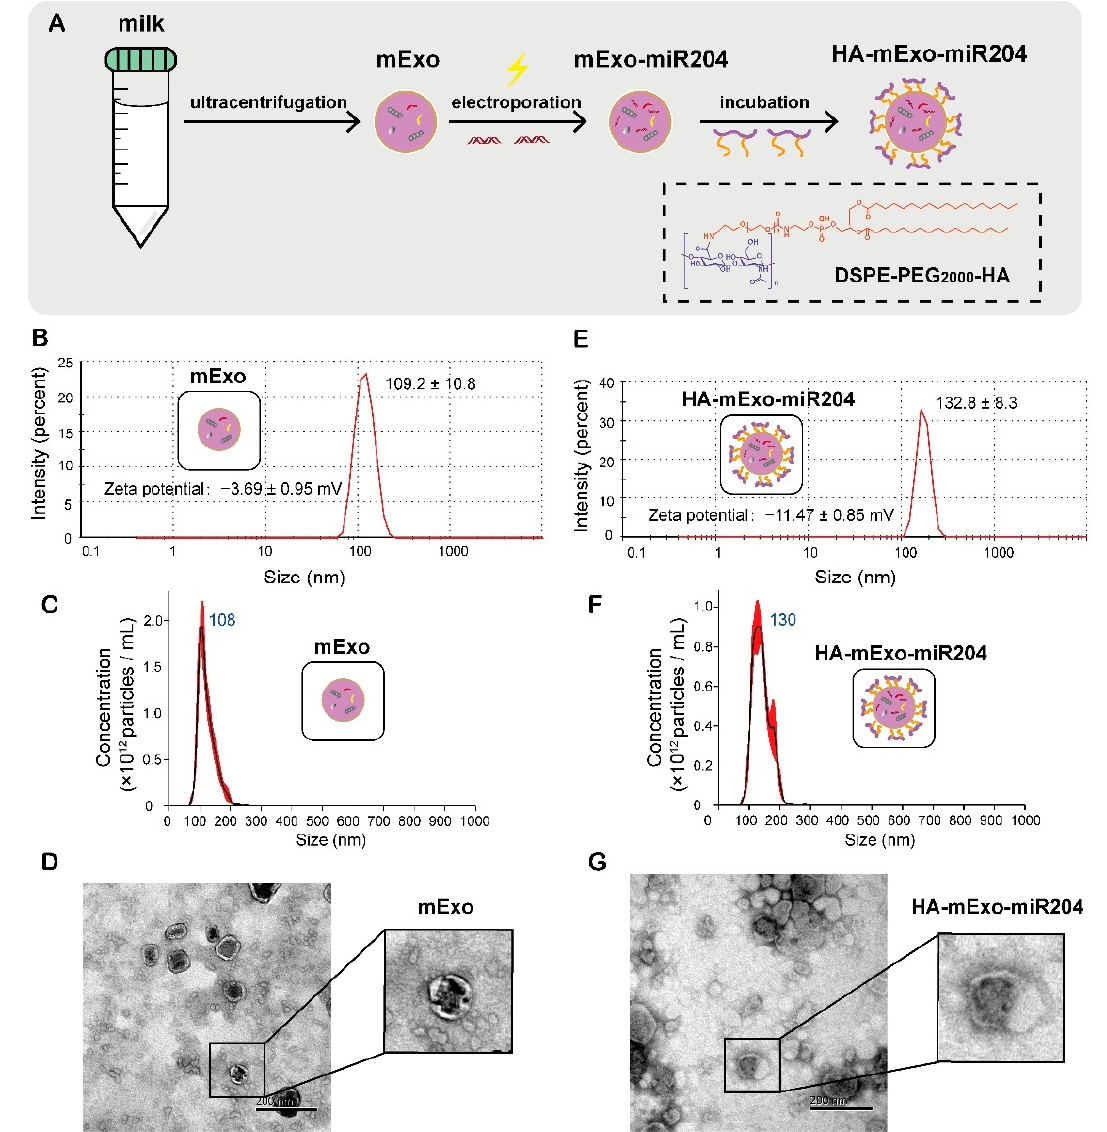
Figure 1. Preparation and characterization of HA-mExo-miR204. ( A ) Schematics of preparation of HA-decorated bovine mExos containing miR-204 (HA-mExo-miR204). Hydrodynamic size and zeta potential of the intact mExos ( B , E ) HA-mExo-miR204 were determined by DLS analyses. Concentra- tion and size distribution of the intact mExos ( C ) and HA-mExo-miR204 ( F ) were determined by NTA analyses. TEM images of the intact mExos and HA-mExo-miR204 were shown in ( D , G ), respectively. Scale bar: 100